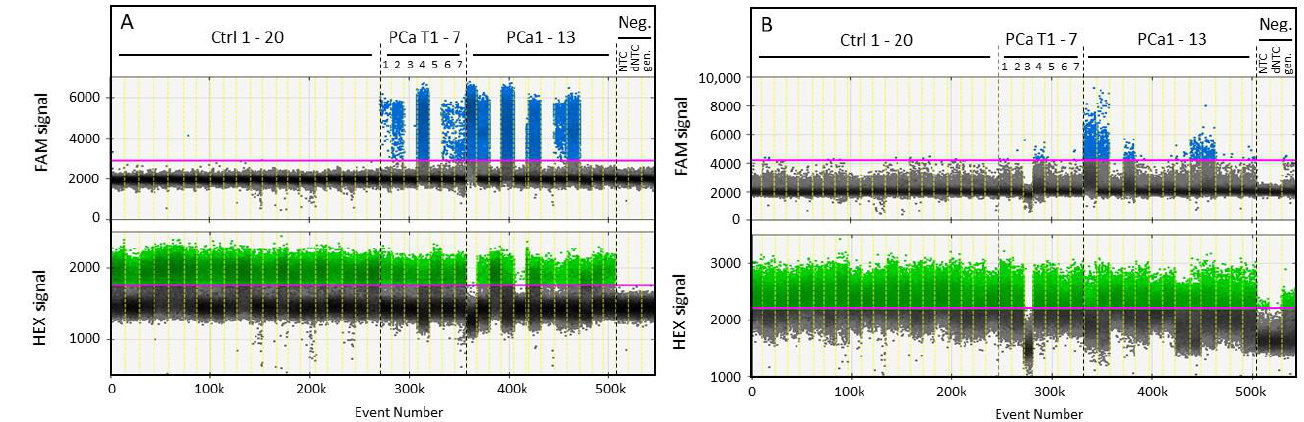
Figure 4. Methylation analyses of GSTP1 DNA fragments in healthy controls and PCa serum pools. The DNA methylation status of GSTP1 was analysed in serum samples of healthy individuals (Ctrl 1–20) and prostate carcinoma (PCa) patients at diagnosis (PCa 1–13) as well as in 1 PCa patient during PCa treatment (PCa T1–T7). The impact of PCR primer design on the analytical sensitivity and signal-to-noise ratio was demonstrated by comparing the OBBPA-ddPCR assay GSTP1-116bp ( A ) with an alternative GSTP1-120bp assay from literature ( B ). Thresholds for FAM signals specific for methylated (blue, upper row) and HEX signals for unmethylated (green, lower row) DNA sequences were 2900/1750 RFU for GSTP1-116bp and 4200/2200 RFU for GSTP1-120bp. As control measurements, unmethylated (0%) and methylated (100%) DNA standards as well as no-template controls (dNTC without and NTC with pre-amplification) were analysed before (−PA) and after (+PA) pre-amplification. Genomic DNA standards without prior bisulfite treatment (gen.) were tested by ddPCR to ensure specific detection of bisulfite treated DNA.